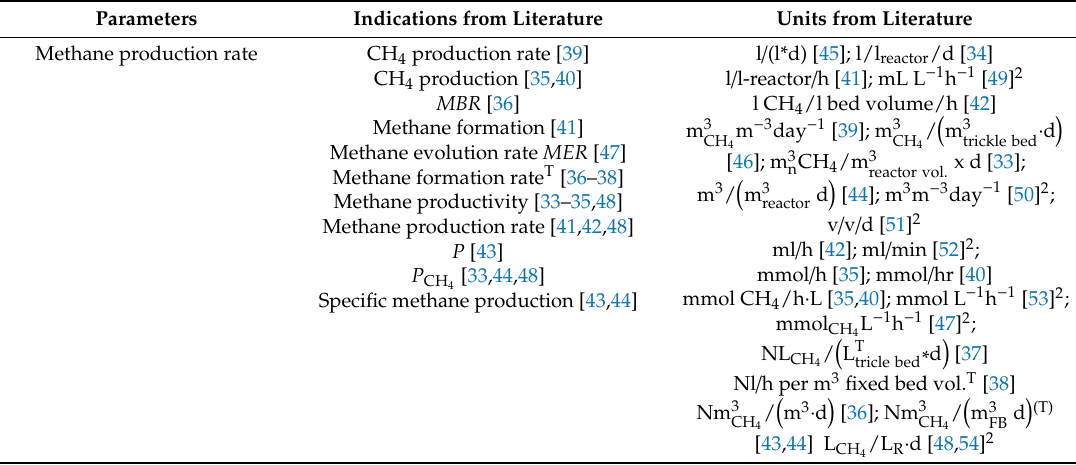
Table 1. Variety in indications and units for the methane production rate in current literature on CO 2 -methanation in trickle-bed reactors. Minor di ff erences in spelling or case sensitivities reflect inaccuracies of indications and units in literature. A summary of indications and units of other relevant parameters for CO 2 -methanation is given in Table A1 in the Appendix